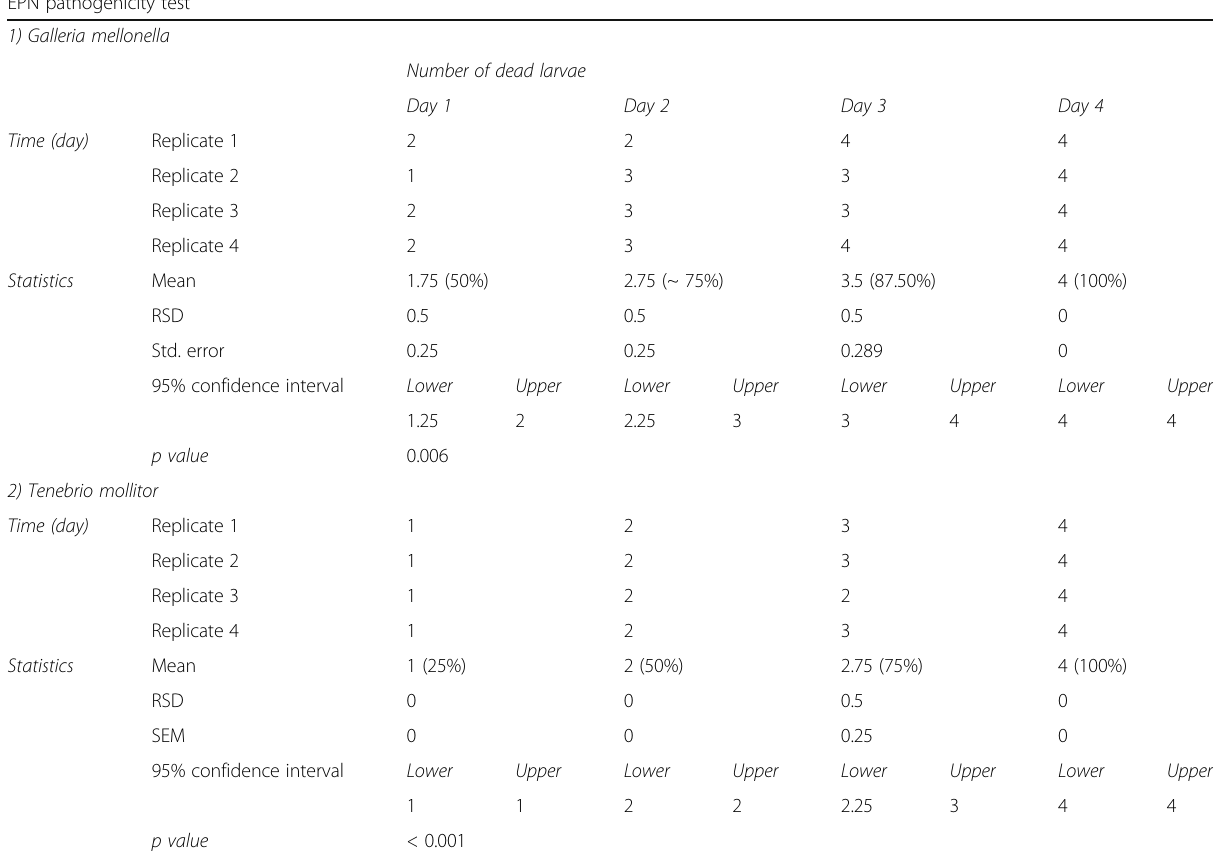
EPN pathogenicity